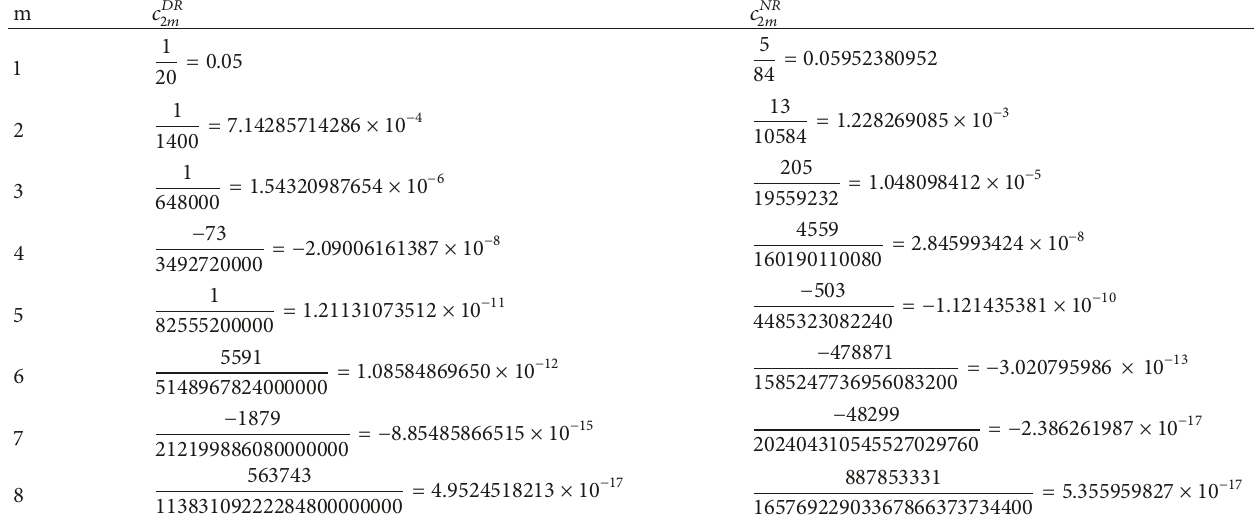
Table 6: The 8 lowest-order expansion coefficients, 𝑐 𝐷𝑅 2≤2𝑚≤16 , implied by the unprecedented high-capacity (high-temperature) 𝑥 2𝑚 𝐷 -series expansion, 𝜅 𝑚 𝑅 𝐷ℎ (𝑥 𝐷 ) (A.11), for the conventional Debye function, 𝜅 𝐷 (𝑥 𝐷 ) (A.1). The same expansion coefficients, 𝑐 𝐷𝑅 2≤2𝑚≤16 , apply also the analogous 𝑥 2𝑚 1 -series expansion, 𝜅 𝑚 𝑅 𝐶1ℎ (𝑥 1 ) (A.15), for the Debye-like component, 𝜅 𝐶1 (𝑥 1 ) (A.13), of the low-energy TA phonon section of the lattice heat capacity. With respect to the latter we give here also the set of the 8 lowest-order expansion coefficients, 𝑐 𝑁𝑅 2≤2𝑚≤16 , which are implied by the analogous 𝑥 2𝑚 1 -series expansion, 𝜅 𝑚 𝑅 𝐶2ℎ (𝑥 1 ) (A.23), for the associated non-Debye heat capacity component, 𝜅 𝐶2 (𝑥 1 ) (A.17).